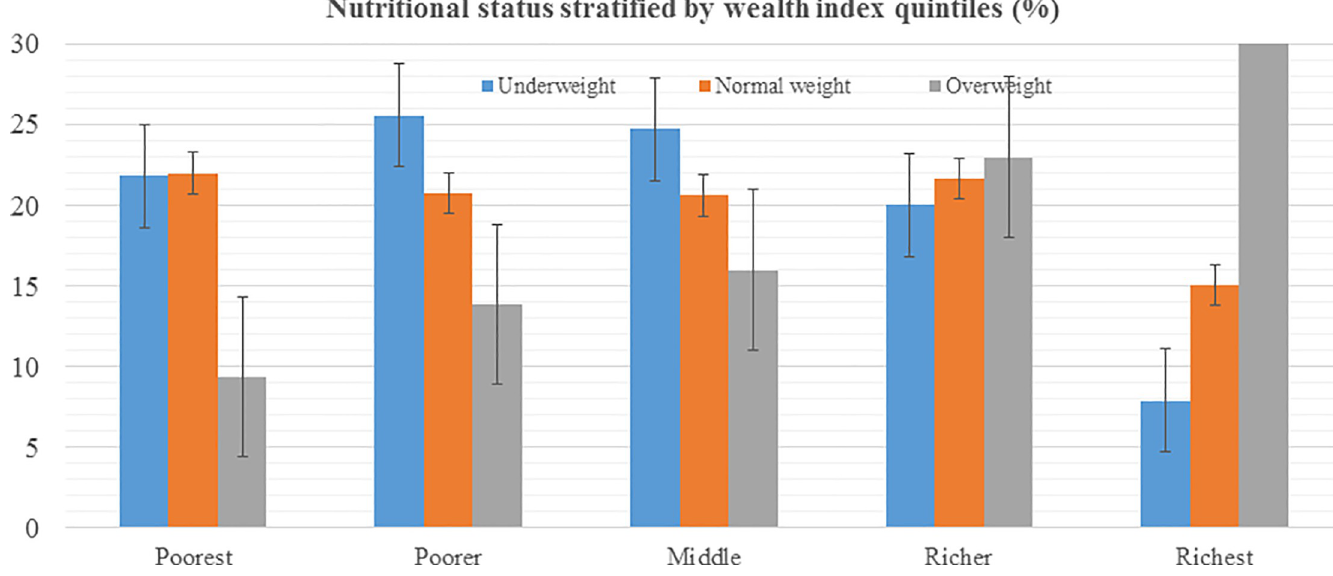
Fig 1. Nutritional status of the participants stratified by wealth index quintile.